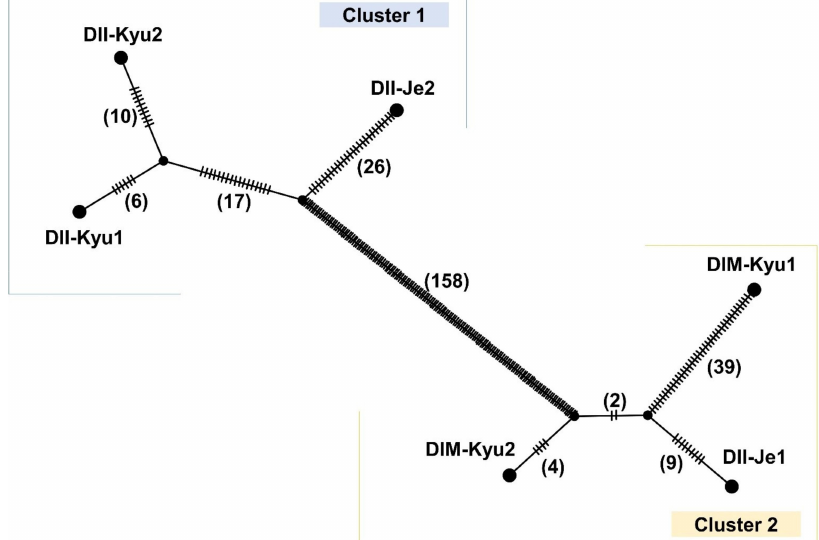
Figure 7. The TCS network based on whole mitochondrial genome sequences of six individuals of Damnacanthus indicus (421,524 bp in aligned length). The morphology of these individuals is available in Figure 1. Large black circles at the tips are each of the individual mitochondrial genomes. The small black circles at the nodes are hypothetical missing intermediates. Branch lengths are not directly proportionate to mutational steps. The number of mutational steps is presented as hatch marks and also in brackets. Open boxes represent each